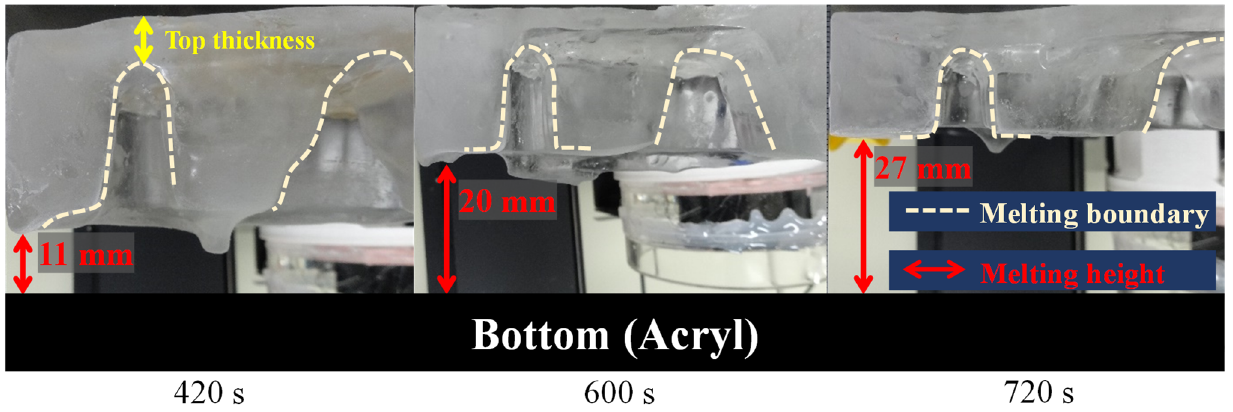
Figure 10. Section view of frozen solution according to heating time (Module_1) (Case_2) (420, 600, 720 s).